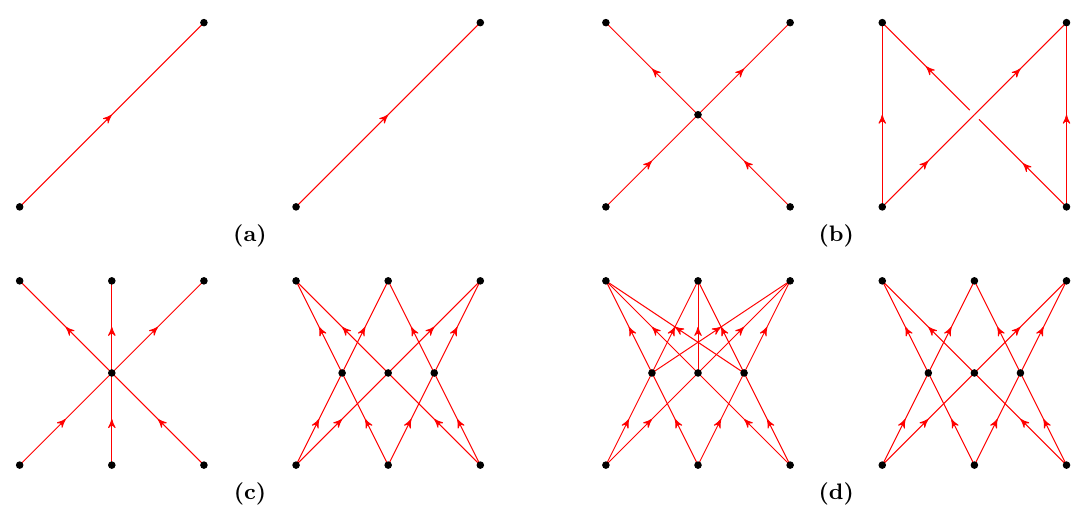
Figure 2. Causal networks. Vertices with no incoming edges are input points, where quantum systems are input to the network, and vertices with no outgoing edges are output points, where quantum systems are output from the network. Here, we show examples of pairs of causal networks which are related by the AdS/CFT correspondence. On the left we show the causal network describing the bulk, on the right we show a (simplified) causal network describing the boundary, with labels corresponding to the configurations shown in figure 1. In (a) the bulk and boundary networks agree, while in the remaining cases they differ. The AdS/CFT correspondence implies that these pairs of networks allow for the same information processing tasks to be completed, when the boundary network has access to whatever entanglement is present in the holographic